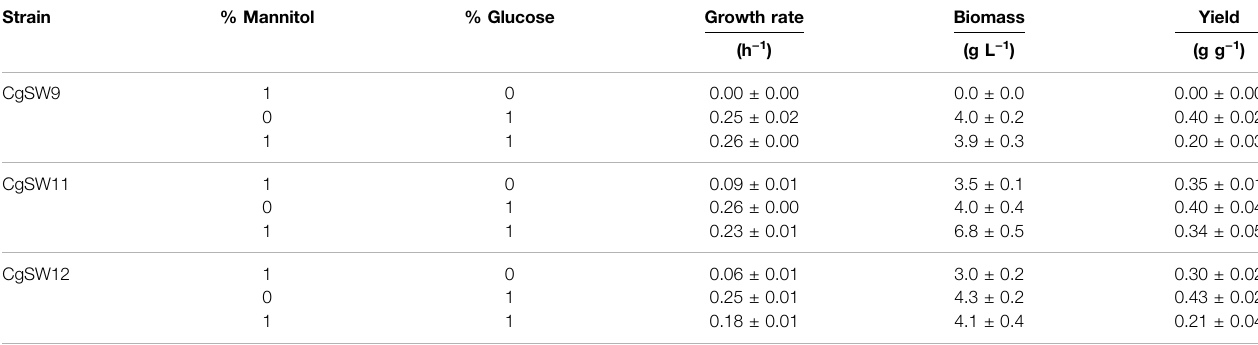
TABLE 4 | Growth values of the strains CgSW9, SgSW11, and CgSW12 when using mannitol, glucose, or mannitol plus glucose as sole carbon sources. Strain % Mannitol % Glucose Growth rate Biomass Yield